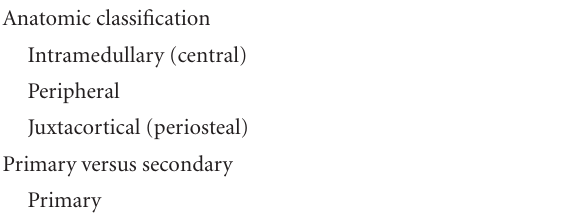
Table 1: Classification of